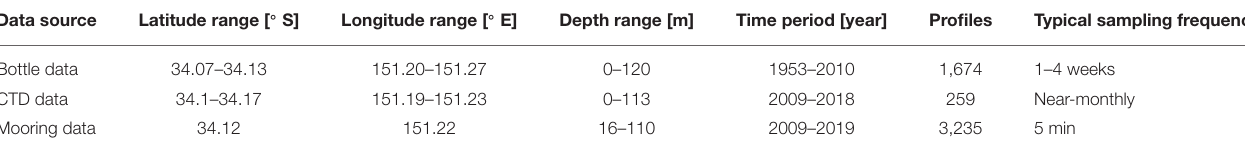
TABLE 1 | Data description, including data source, location (latitude and longitude), depth range, time period, number of vertical profiles for each data type, and typical sampling